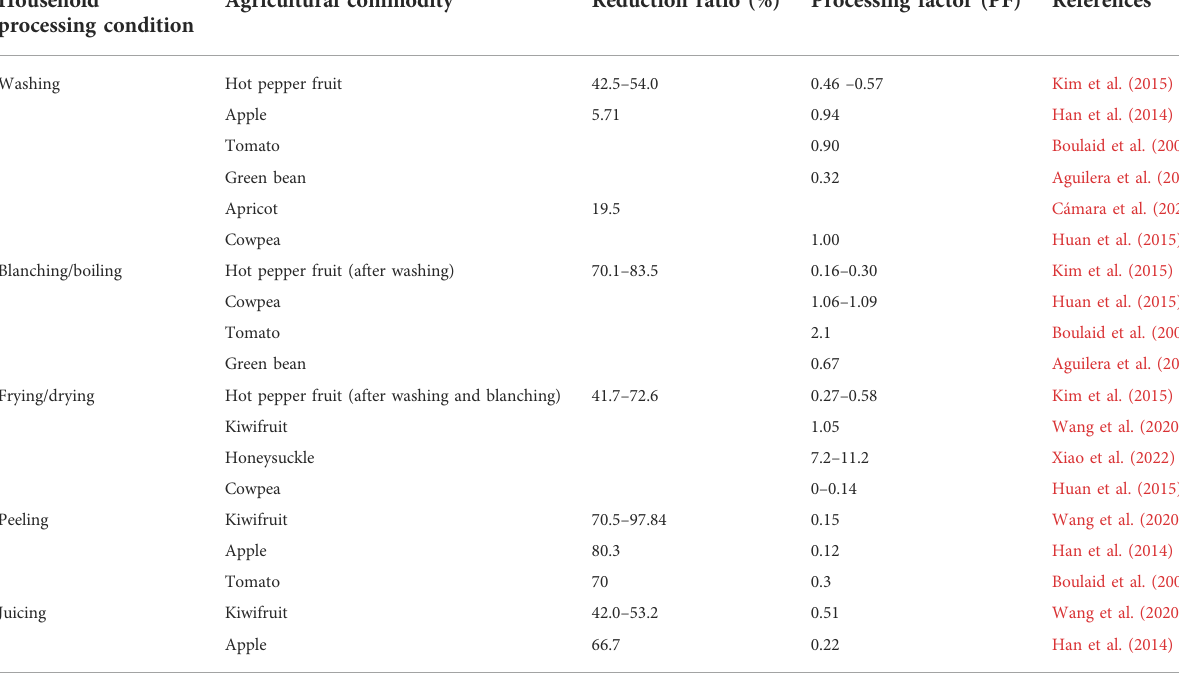
TABLE 1 Effect of house processing techniques on pyridaben